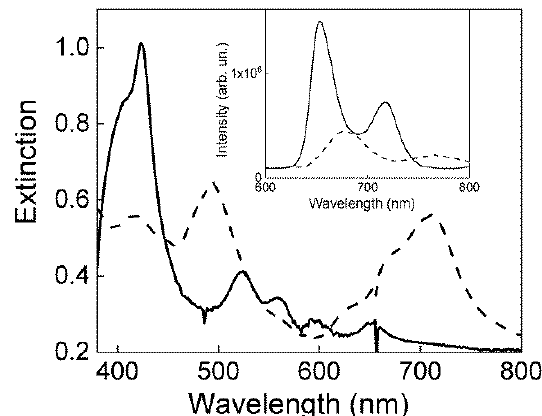
Figure 3. Extinction and fluorescence emission (inset) spectra of s-PEEK-0.77 composite membranes re-cast from DMAc (black dashed line) and after dipping into alkaline NaOH, 1 M solution (black solid line) at 25 ◦ C.